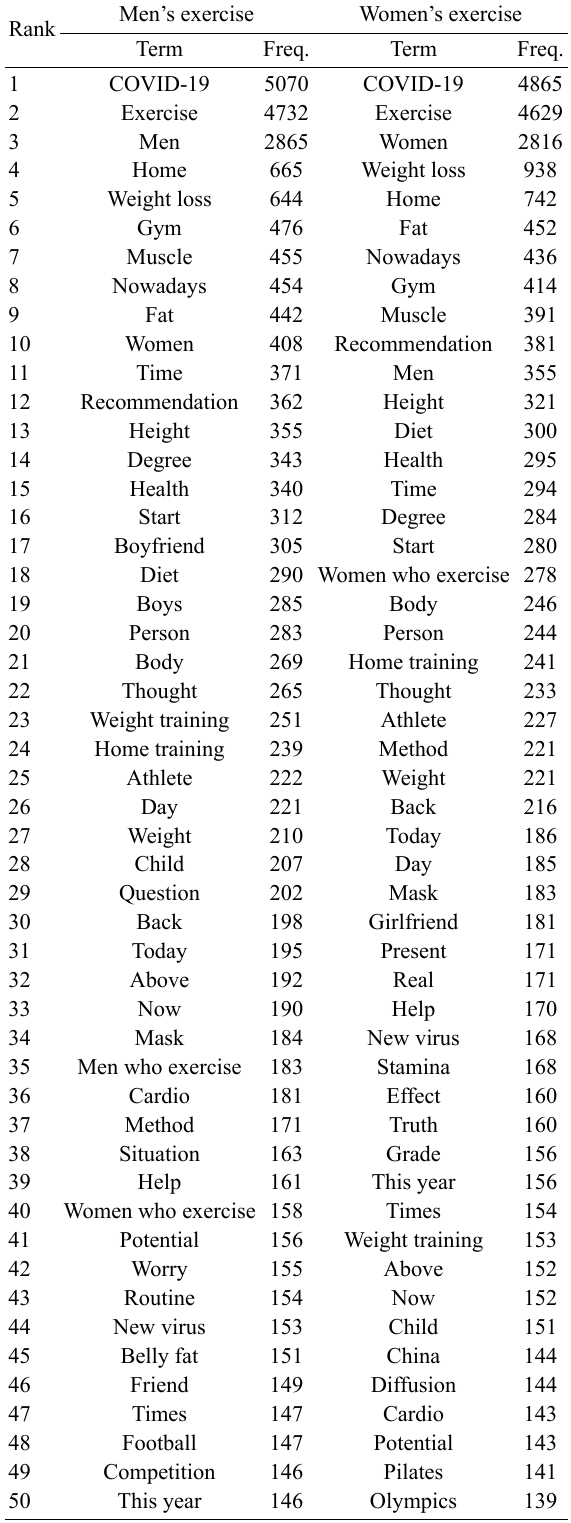
Table 3. Results of the frequency